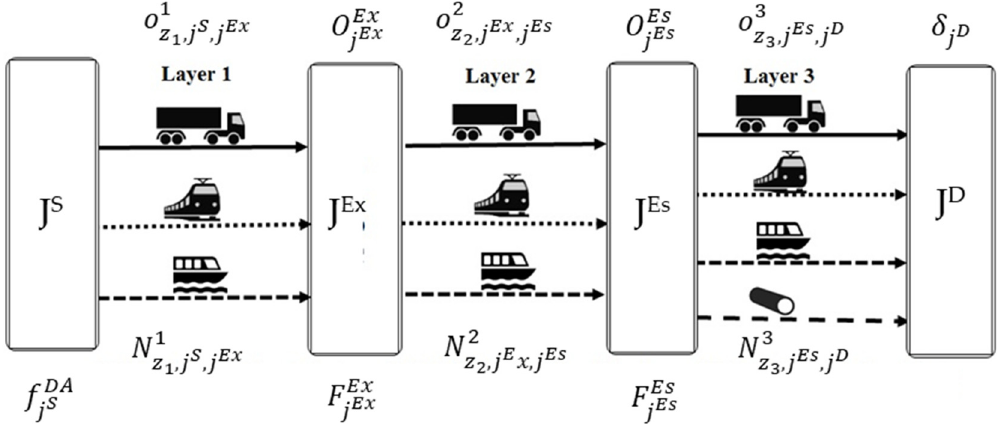
Figure 5. Variables for transportation between each production layer.